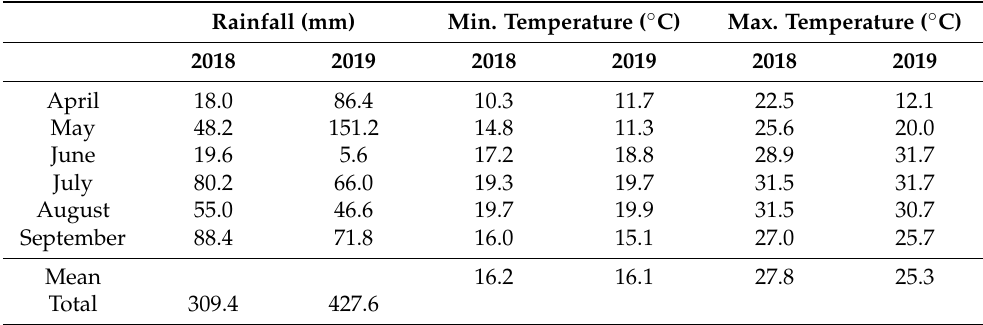
Table 1. Monthly total rainfall and temperature (minimum and maximum) at the experimental field of Rovigo during the two growing seasons, 2018 and 2019.